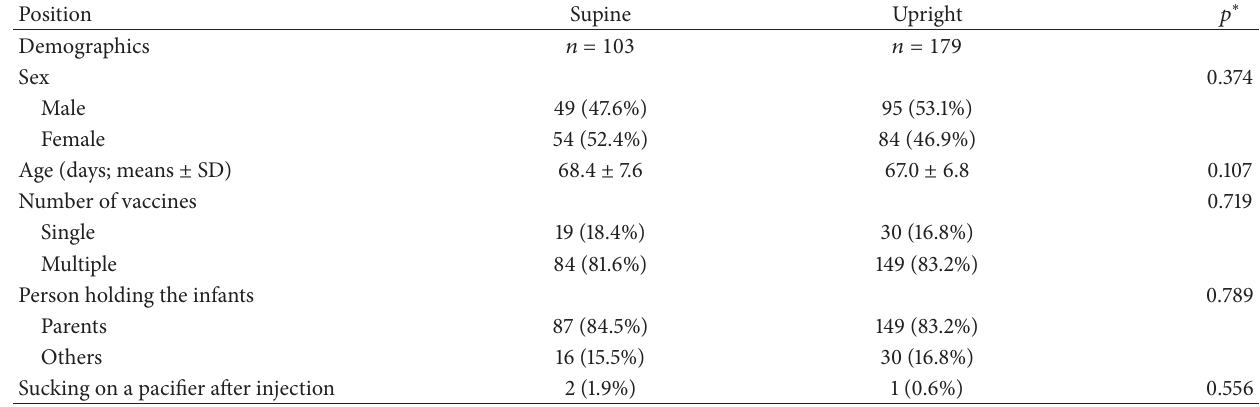
Table 2: Infant demographic